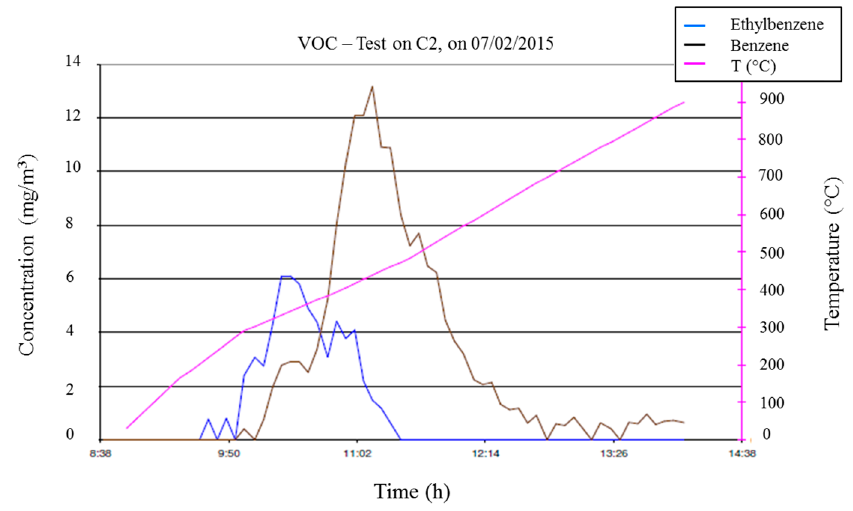
Figure 6. Example of a kinetic curve of ethylbenzene and benzene emissions in paste C.